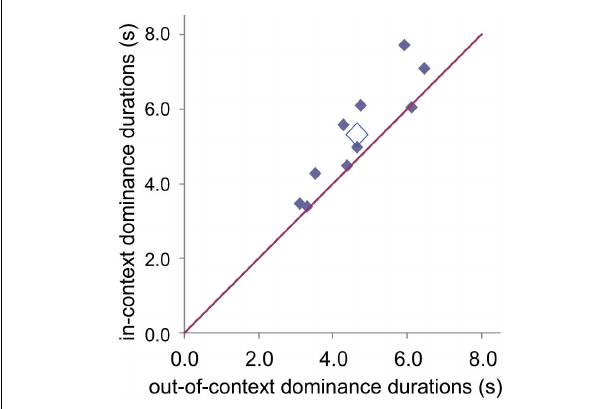
FIGURE 8 | Mean dominance durations of in-context vs. out-of-context idiom texts, for each subject (filled diamonds) and across-subject means (open diamond). In-context dominance duration is generally longer than out-of-context